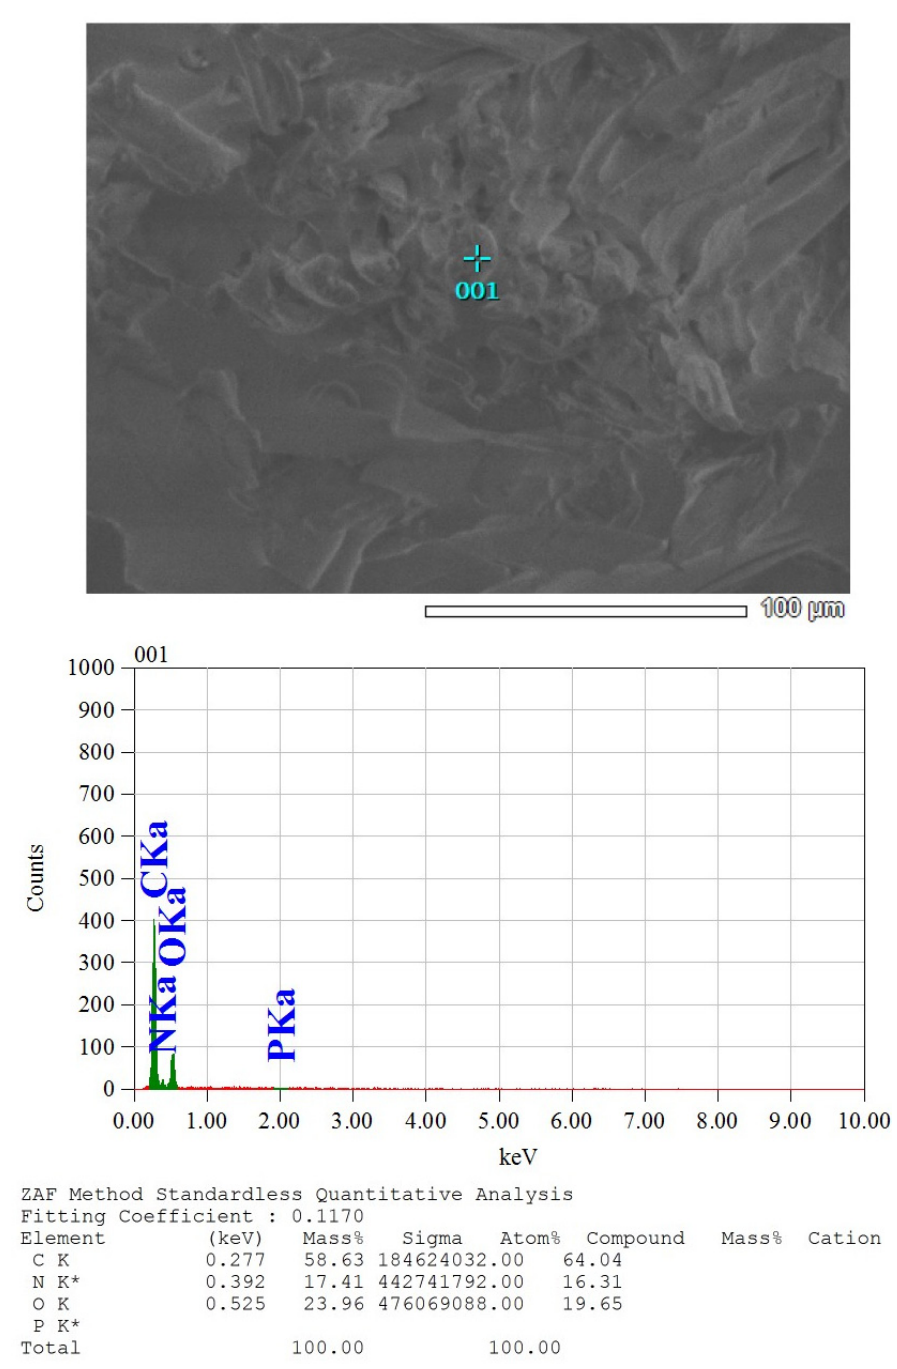
Figure 6. Explain of Energy-dispersive spectroscopy analysis of JCJC spent tea leaf composites.